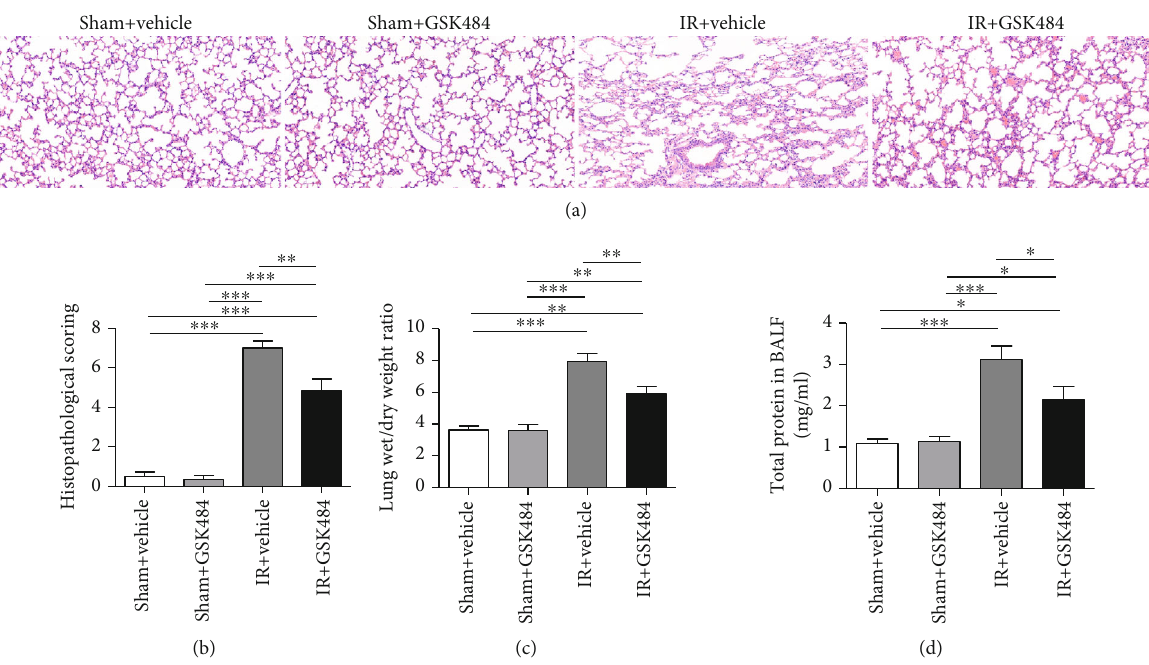
Figure 2: E ff ect of GSK484 on renal IR-induced pulmonary injury. (a) H&E staining of lung sections from di ff erent groups (scale bar: 50 μ m). (b) Histological analysis of di ff erent conditions. (c) W/D weight ratio of pulmonary tissue. (d) Protein leakage in the bronchoalveolar lavage fl uid (BALF). The values are means ± SEMs ; n = 6 ; ∗ p < 0 : 05 , ∗∗ p < 0 : 01 , and ∗∗∗ p < 0 : 001 (Figure 2(c) p < 0 : 01 compared with that in the IR+vehicle group) and BALF total protein (Figure 2(d) p < 0 : 05 compared with that in the IR+vehicle group).